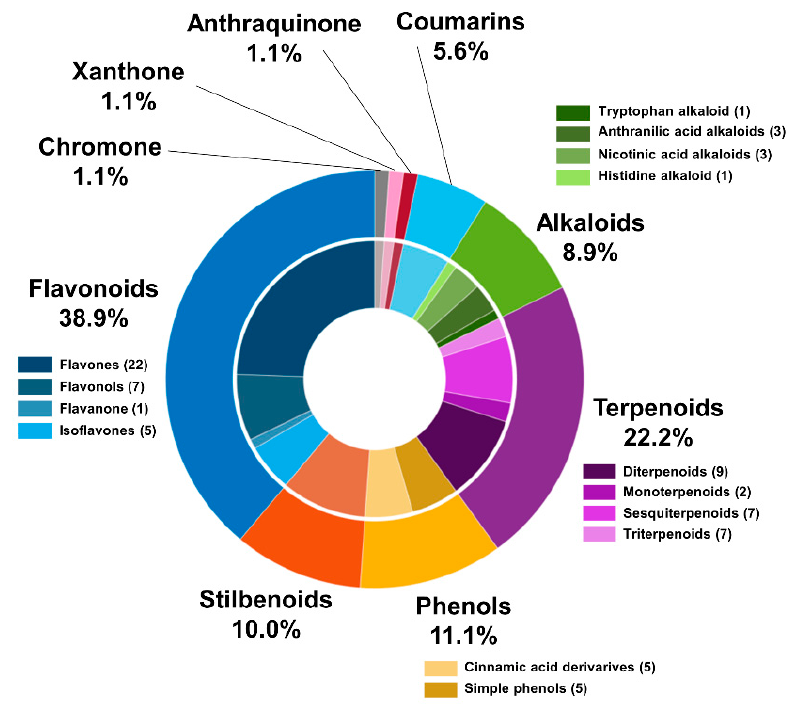
Figure 1. Chemical classes of the compounds annotated from Vanda and Cattleya genera obtained by LC-HRMS/MS in positive ion mode ESI.